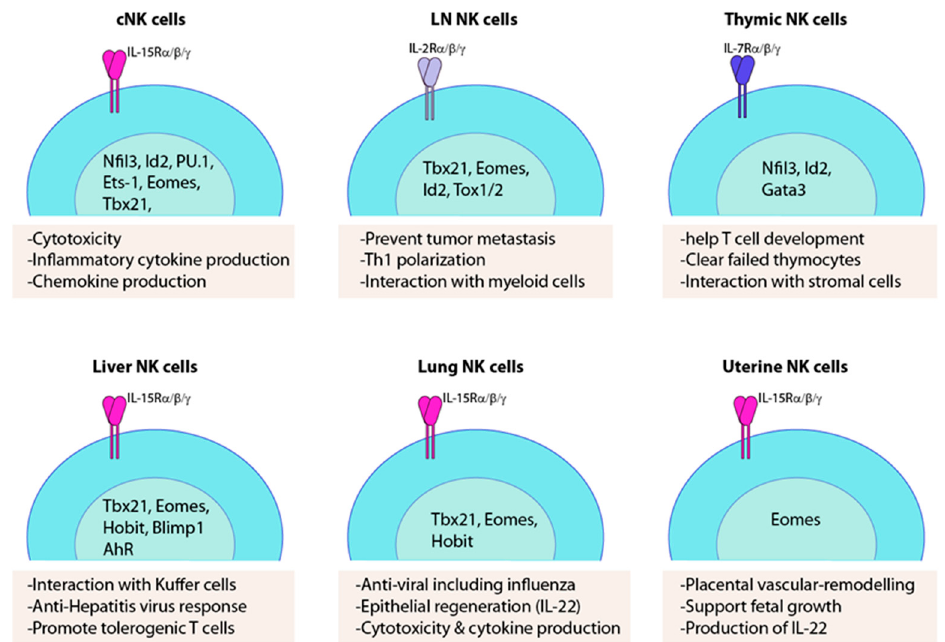
Figure 2. Unique transcription factor requirements and functions of trNK cells. Major common gamma chain receptor involved in the development of tissue-specific NK cells are indicated. Essential transcription factors that have been demonstrated are shown. A few of the defined functions of the trNK cells are listed under each subset.